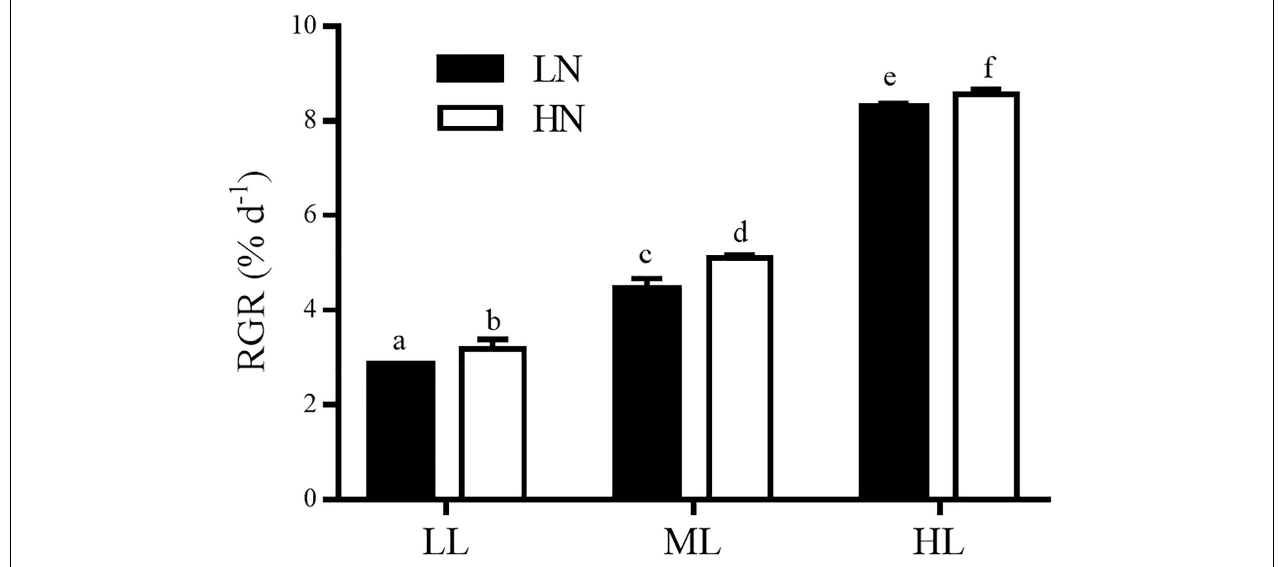
FIGURE 1 | Relative growth rates (RGRs) in Sargassum muticum grown at different light and nitrogen levels, which were determined during 2 days at the end of 12 days of incubation. Significant ( P < 0.05) differences among the treatments are indicated by different lowercase letters. Vertical bars represent ± SD for the means of three samples. TABLE 1 | Photosynthetic parameters from the P − E curves of Sargassum muticum cultured under different light and nitrogen conditions.